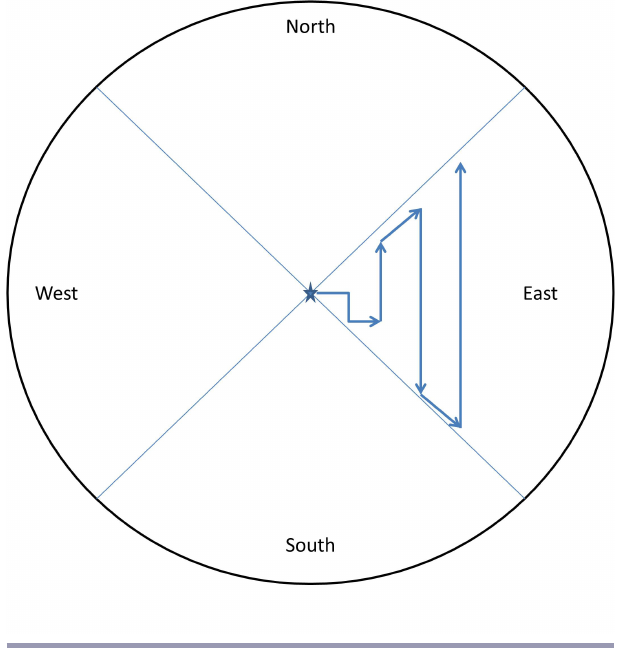
Fig. 1 . Percent exposed ground (PEG) sampling method. The star in the center represents the sample location. The PEG was estimated by looking straight down and walking a path in each quadrant, as indicated by the arrows. The PEG was sampled in the four cardinal directions and averaged for the location. Circle radius is 5